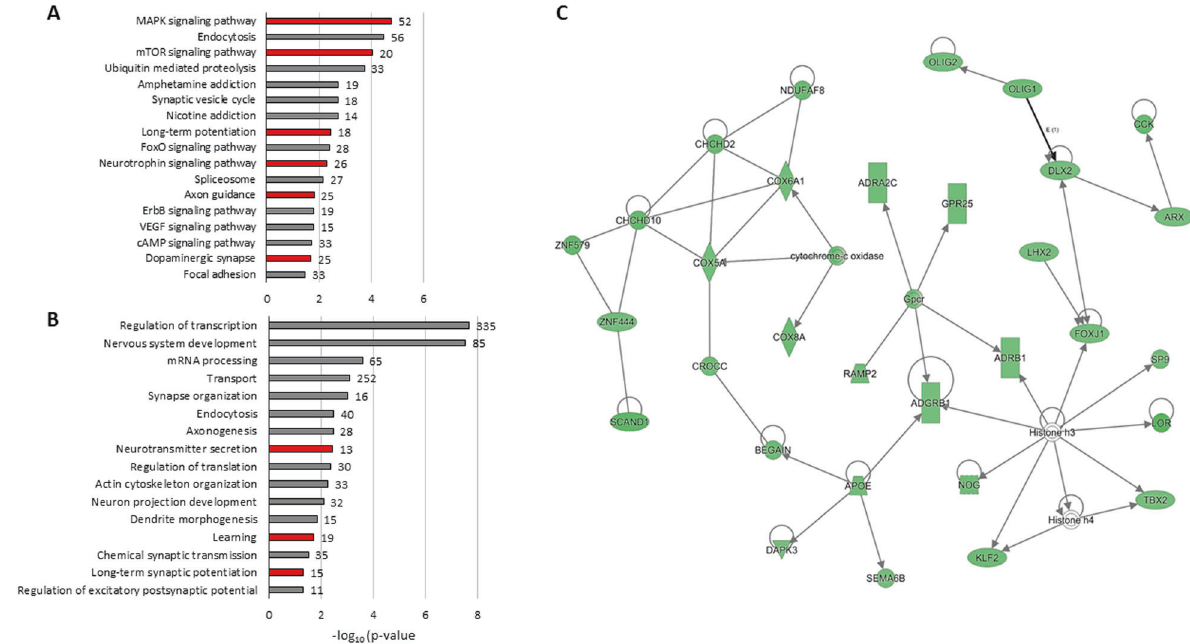
Fig. 3 Gene expression changes in mPFC after cue-induced reinstatement of cocaine-seeking in Plcb1 + /- vs wild-type (WT) mice. A Selection of over-represented KEGG pathways (Kyoto Encyclopedia of Genes and Genomes) and ( B ) GO (Gene Ontology) identi fi ed by DAVID software among the differentially expressed genes. The number of genes with altered expression included in